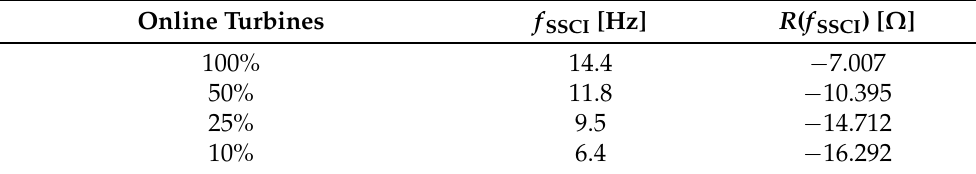
Table 3. Online turbine variations.